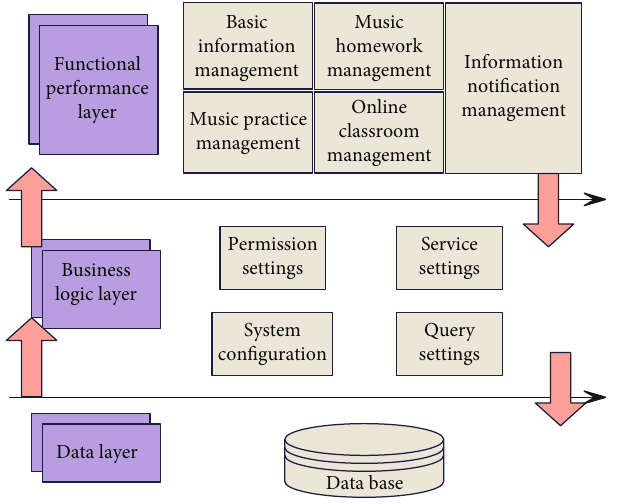
Figure 2: The architecture of the system.